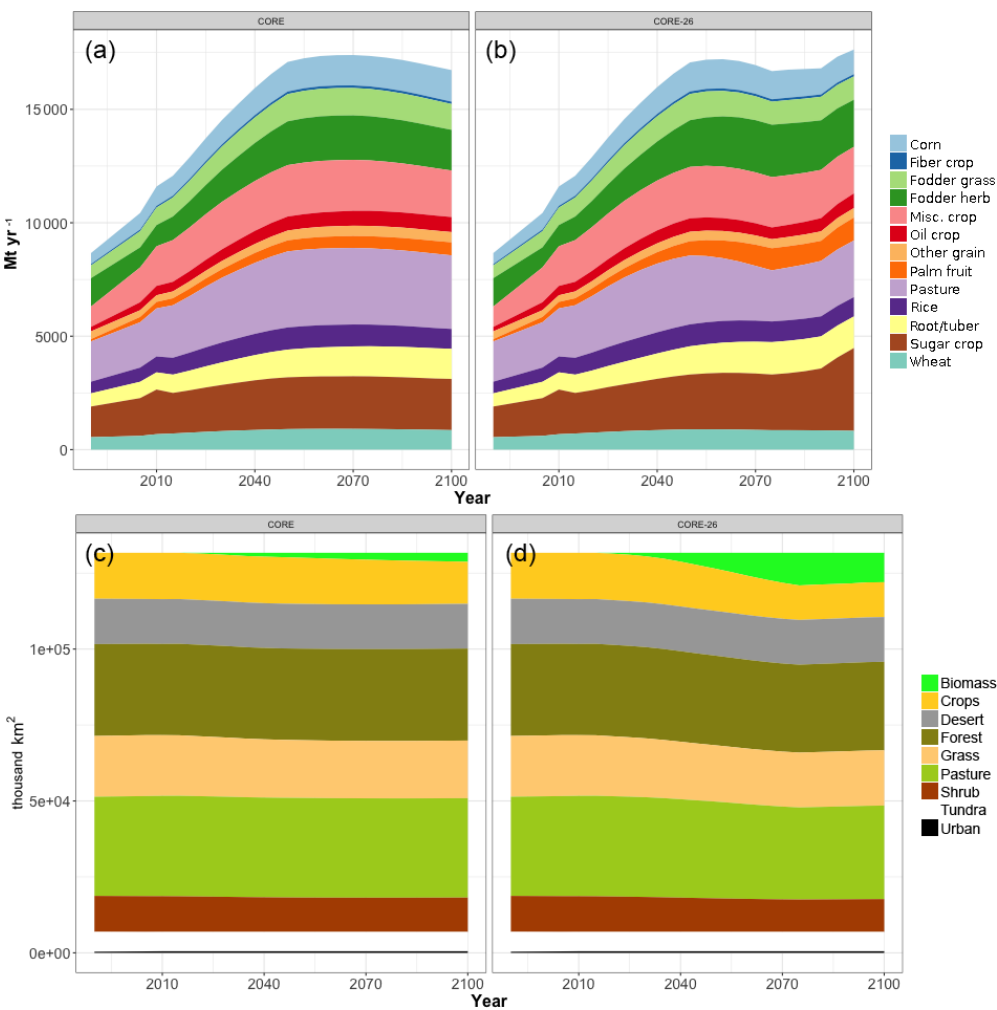
Figure 7. Global agricultural production (a, b) and global land allocation (c, d) for the CORE (a, c) and CORE-26 (b, d) scenarios. Note bioenergy and forest are excluded from agricultural production (a, b) as they are modeled in different units, EJyr − 1 and m 3 yr − 1 , respec- tively. Land cover data (c, d) are aggregated from the more detailed categories included in GCAM v5.1 for plotting purposes.